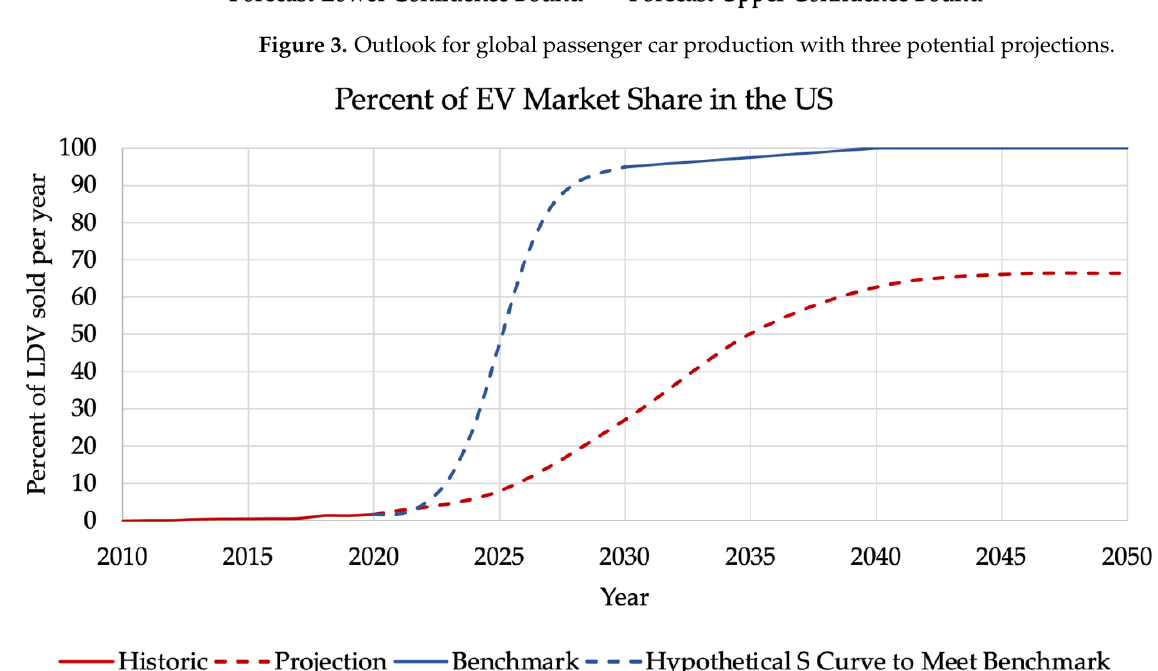
Figure 4. A S-curve created with data from Climate Action Tracker [5] and based on that made by the WRI [6] to demonstrates the growth of passenger EVs.